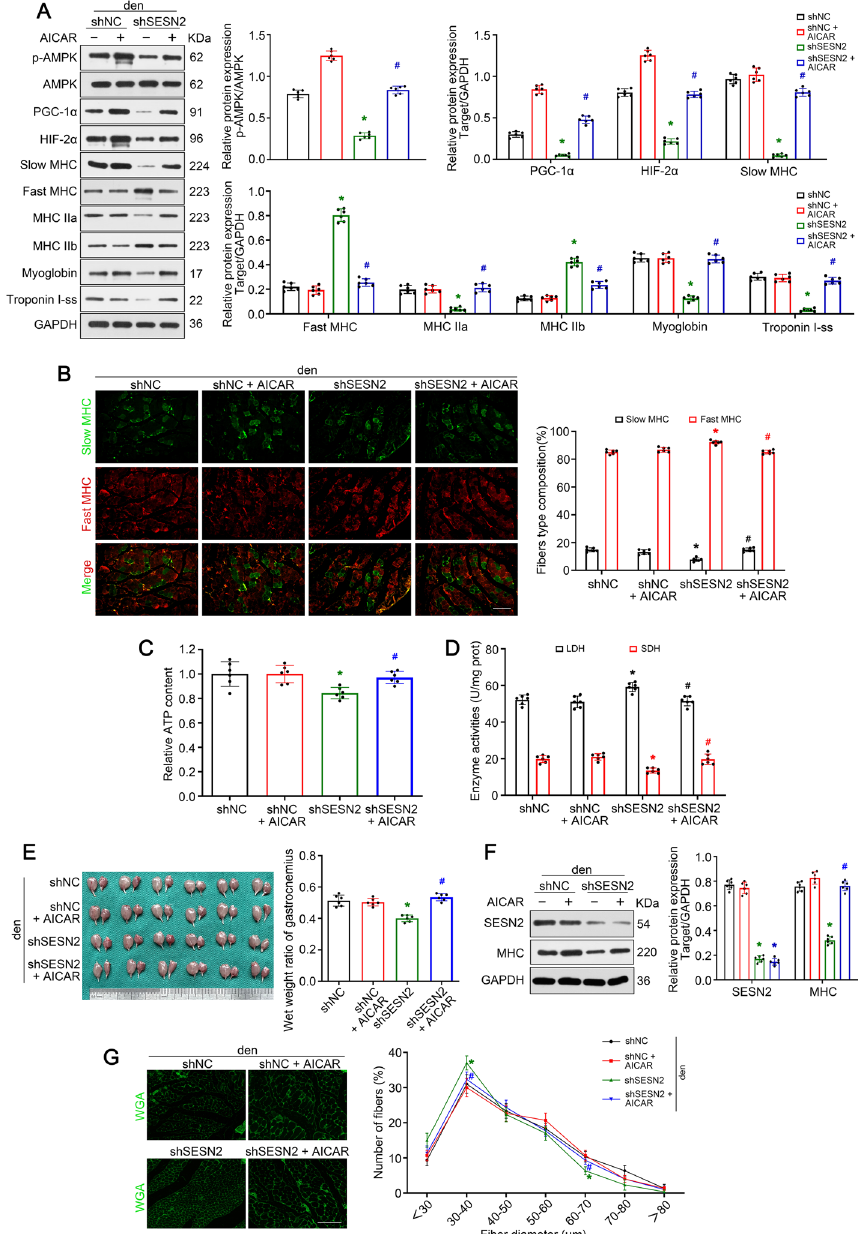
Fig. 7 AMPK/PGC-1α signaling prevented slow-to-fast myofiber shift and protected against muscle atrophy upon denervation. A Western blot analysis confirmed the role of AMPK/PGC-1α signaling in myofiber type transition in denervated GAS. B Immunofluorescence analysis of fiber type composition in denervated GAS. Scale bar, 50 μm. C , D Relative ATP content and metabolic enzyme activities (LDH and SDH) in GAS with different treatment. E Appearance and wet weight ratio of GAS in different groups. F Western blot analysis confirmed the expressions of SESN2 and MHC . G Quantification of muscle fibers diameter by immunofluorescence staining of WGA. Scale bar, 50 μm. Data presented as mean SD. n 6. * P < 0.05 versus ± = denervation shNC group. # P < 0.05 versus denervation shSESN2 group. Den + +